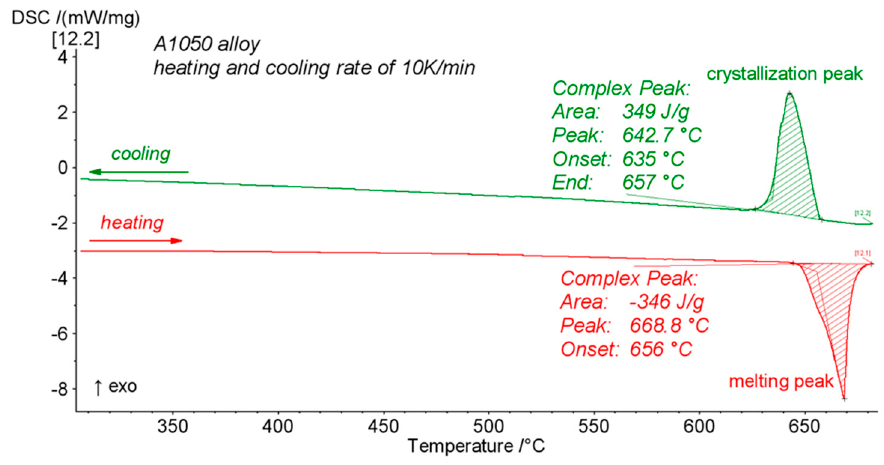
Figure 6. DSC curve registered for A1050 plate with the heating rate of 10 K/min.